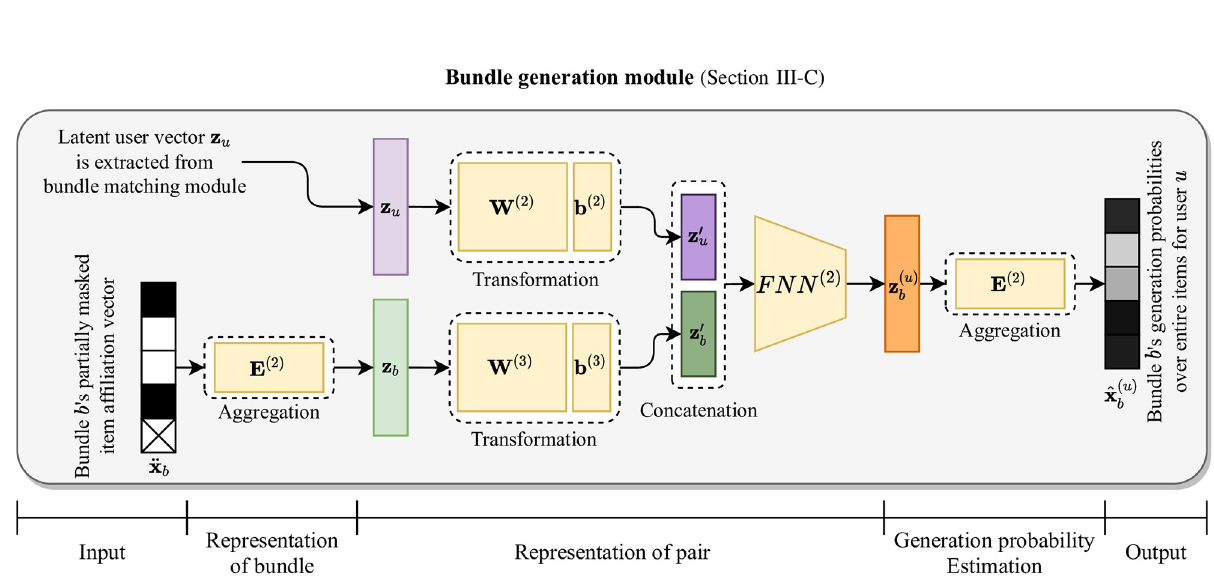
Fig 3. The architecture of bundle generation module in BundleMage.